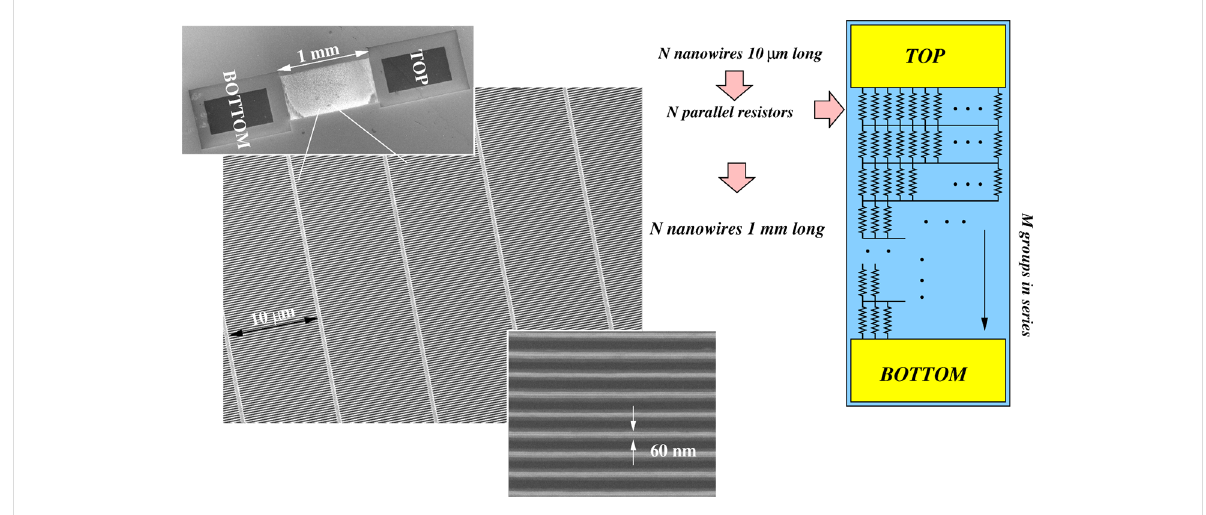
Figure 11: Composition of SEM images of a large area network with a different texture, with respect to Figure 10. An huge number of nanowires, 10 μ m long and 60 nm wide, are placed in series and in parallel. The top right sketch shows a resistor network, that represents the silicon nanowire network both from the electrical and from the thermal point of view. Reproduced with permission from ref.[101], Copyright 2013 American Chemical Society.